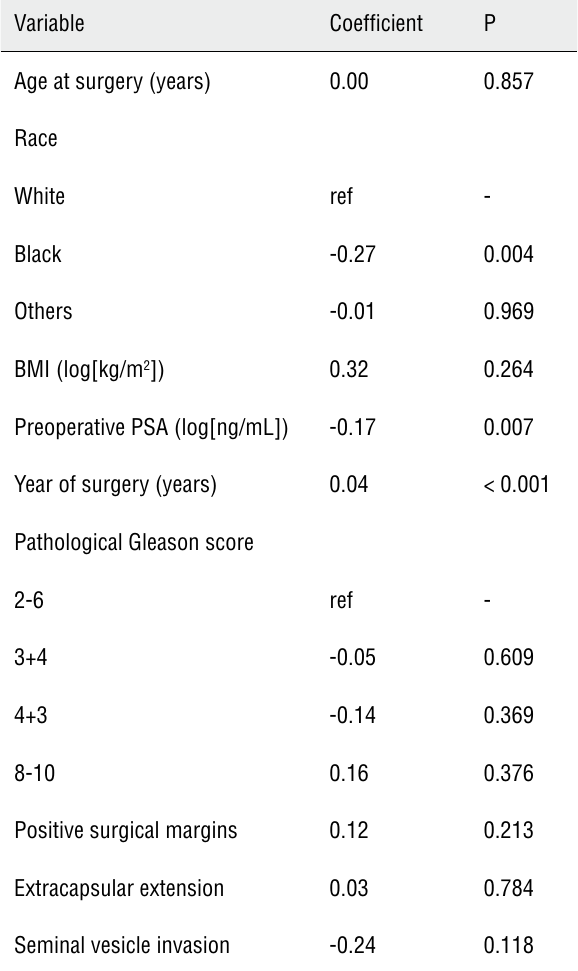
Table 2 - Association of serum folate levels with patient and tumor